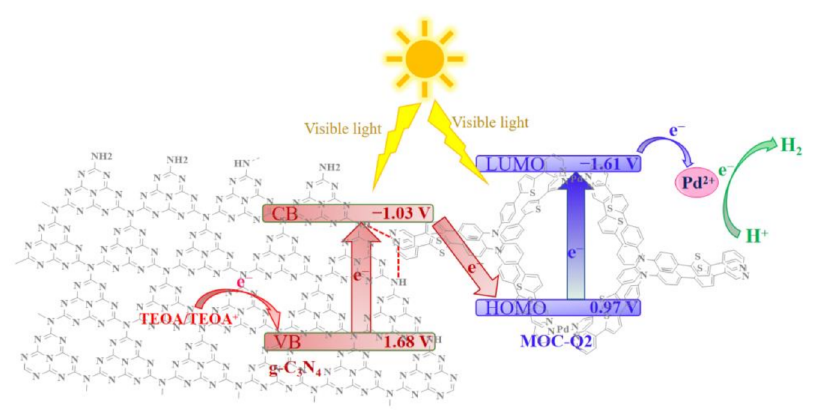
Figure 9. Proposed direct Z-scheme mechanism of g-C 3 N 4 /MOC-Q2 photocatalyst for H 2 evolu- tion